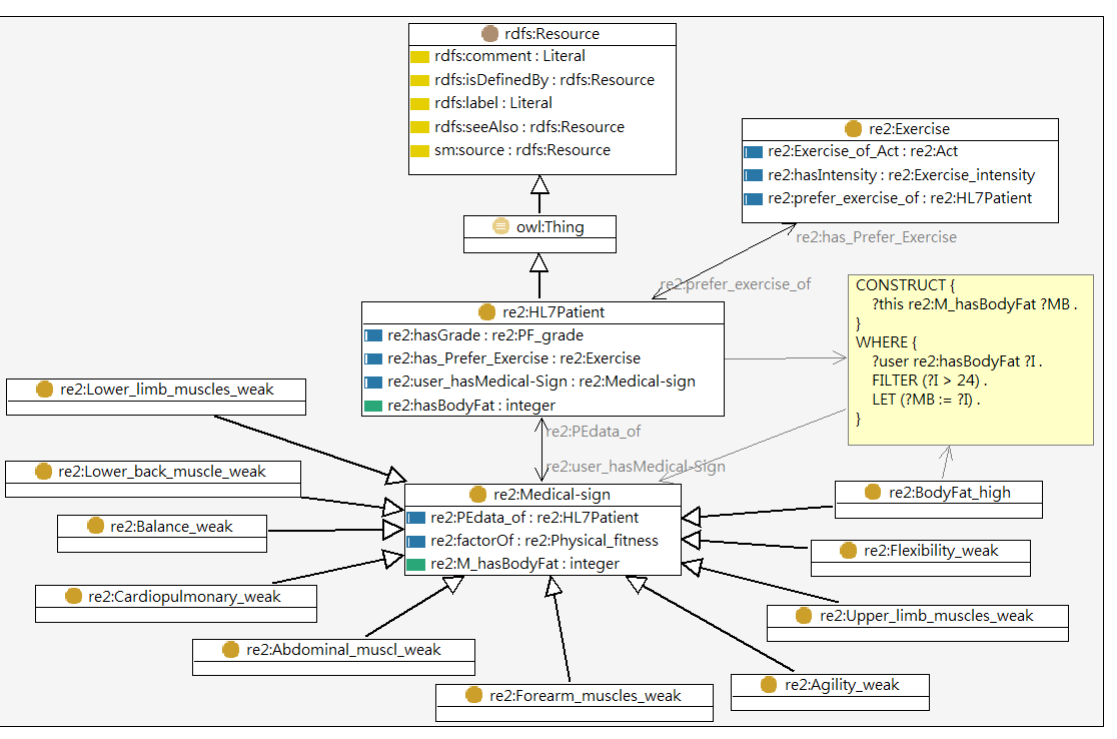
Figure 4. UFIT three ontologies-driven knowledge